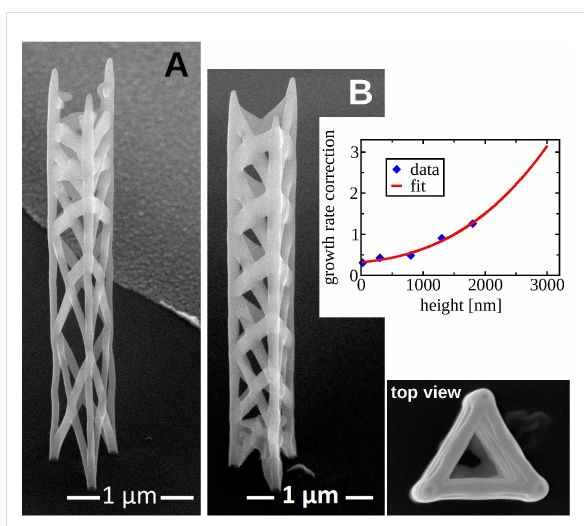
Figure 10: Height correction: Both left images are taken from a 52° tilted view. (A) is deposited without height correction. From height measurements of this deposit the height correction function was gained (red continuous line in the plot). With the corresponding fit coef- ficients the pattern file for deposit (B) was generated. Note the almost equidistant floors of (B). Especially in the upper floor levels a pro- nounced improvement is visible in comparison to (A). Precursor: Me 3 CpMePt(IV), high-resolution mode.